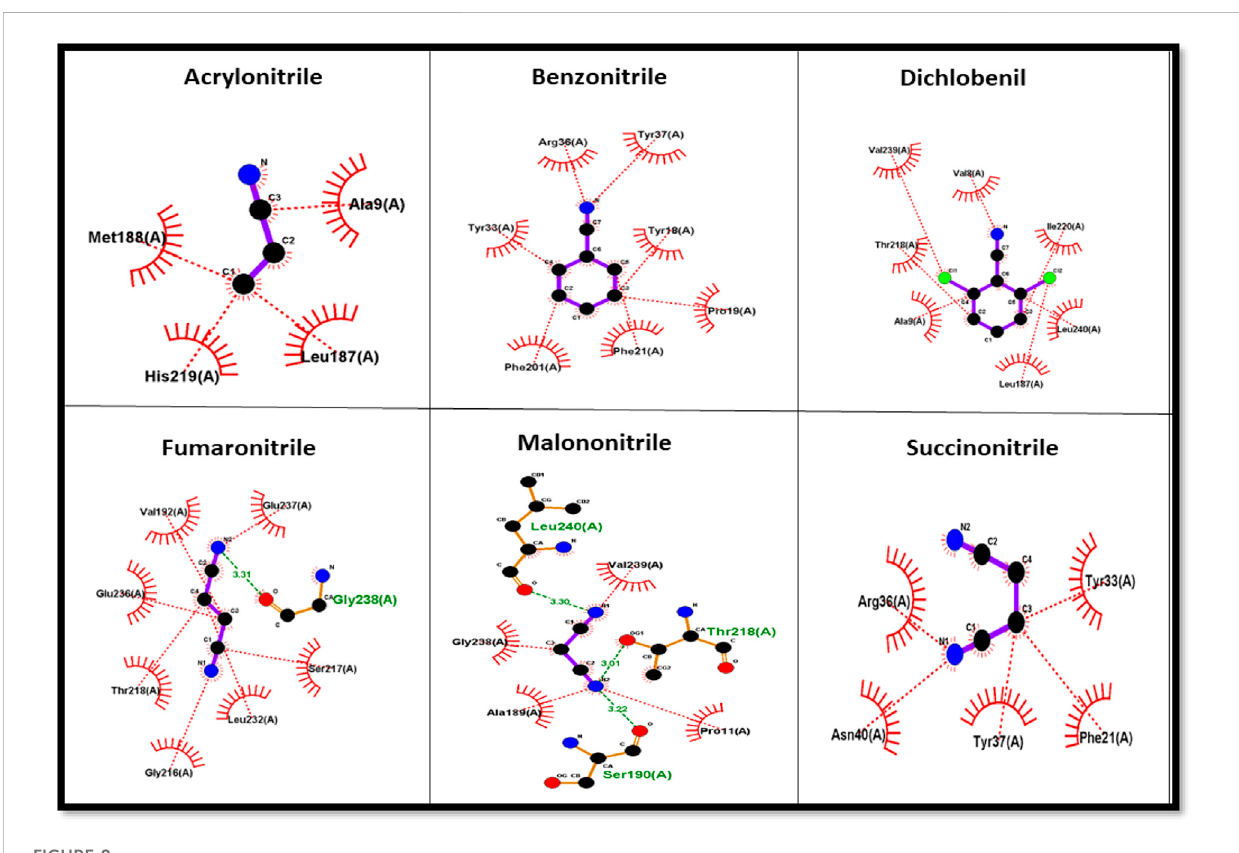
FIGURE 8 Amino acid interaction with nitrile